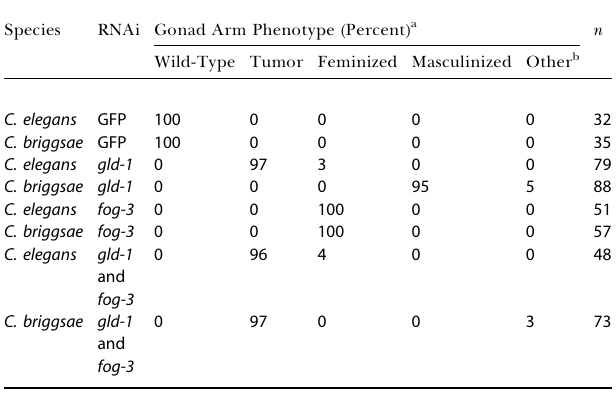
Table 2. Summary of GLD-1 RNAi Germline Phenotype in C. elegans and C.